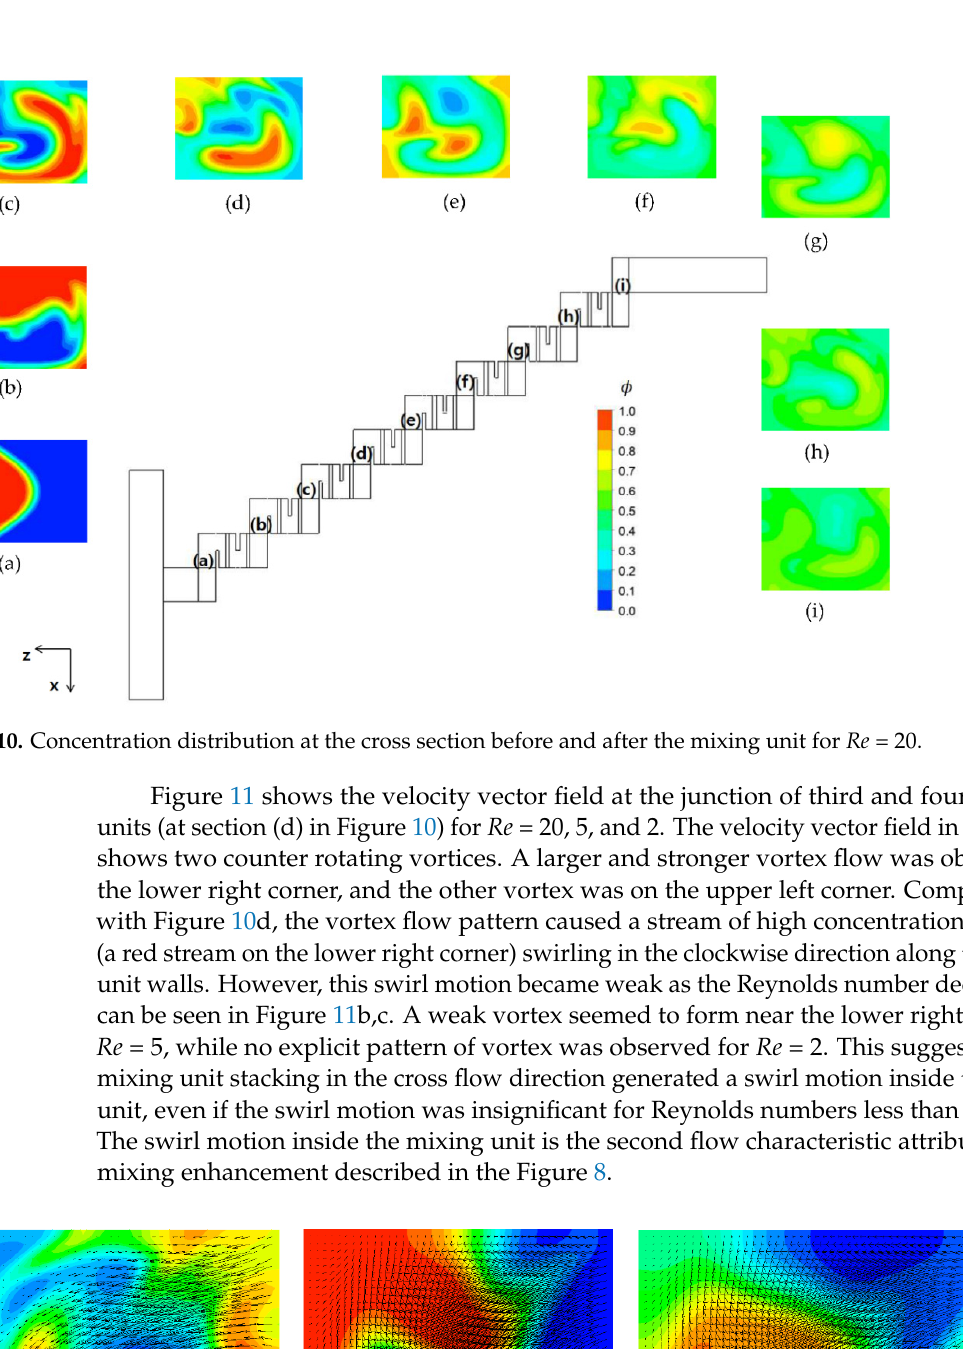
Figure 11. Velocity vector field at the junction of the third and fourth mixing units. Figure 10. Concentration distribution at the cross section before and after the mixing unit for Re = 20.